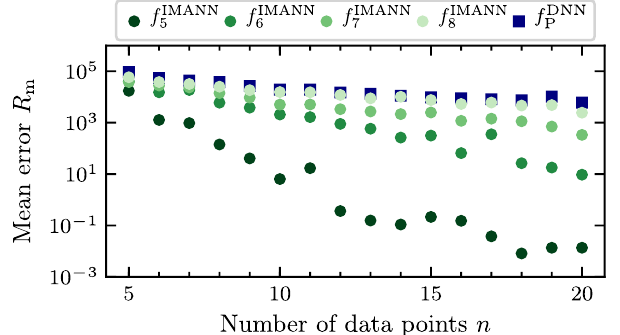
Figure 6. Mean integral squared error R m for algorithms f IMANN numerousness of dataset.